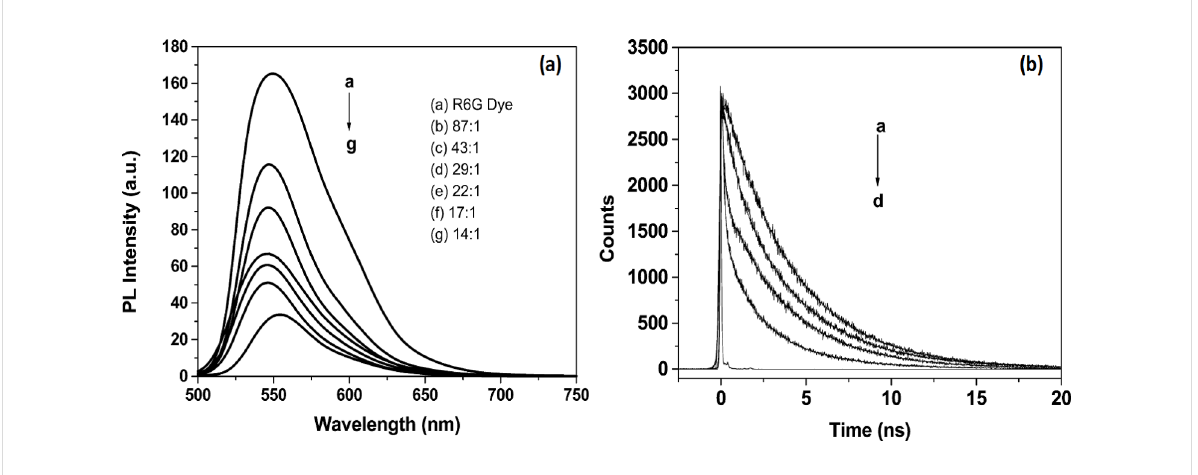
Figure 9: Fluorescence spectra (a) of rhodamine 6G in the presence of Au–ZnO nanostructures and kinetic traces (b) of rhodamine 6G dye solution, Au and 1 μ M R6G, Au and ZnO nanoparticle mixture and 1 μ M R6G, and Au–ZnO core–shell with 1 μ M R6G. Adapted with permission from [125] Copyright (2008) American Chemical Society. This content is not subject to CC BY